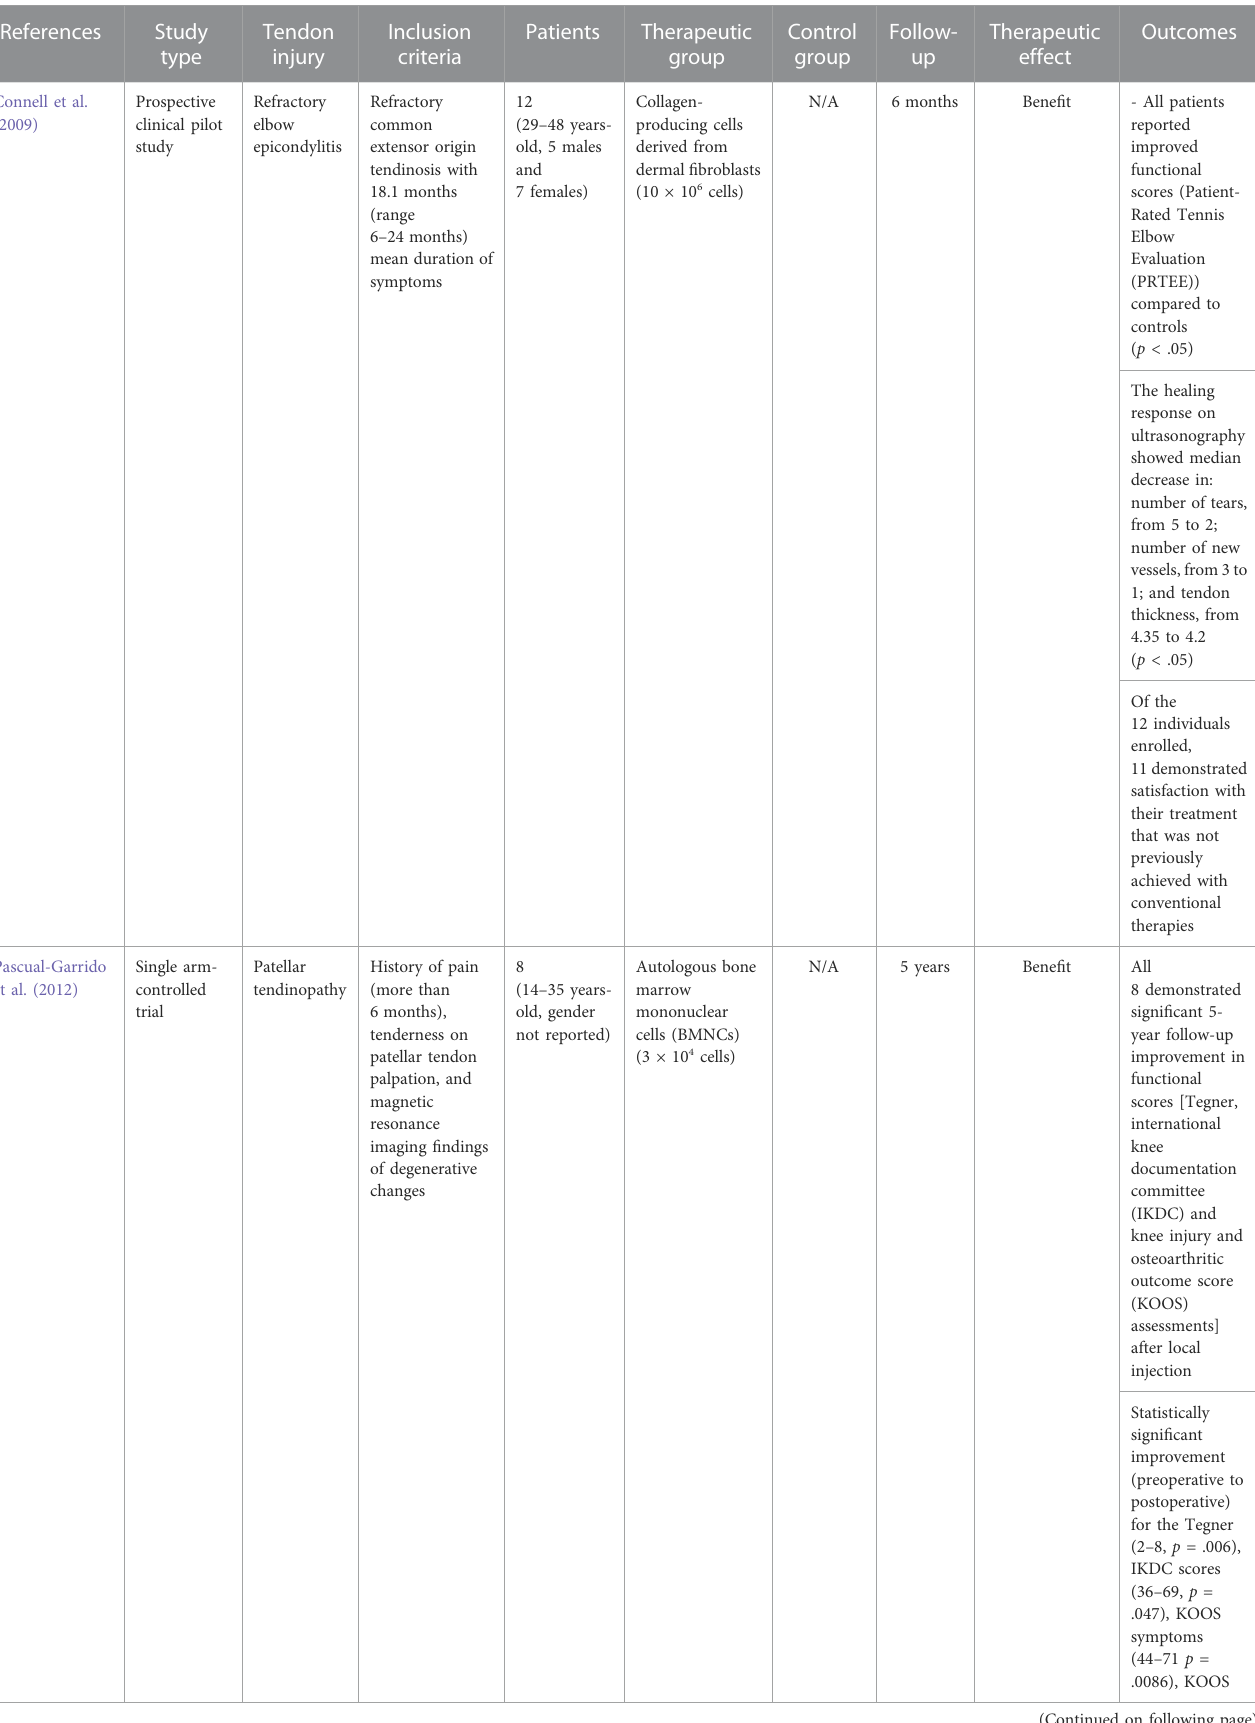
TABLE 2 Clinical studies using MSC-based therapy for